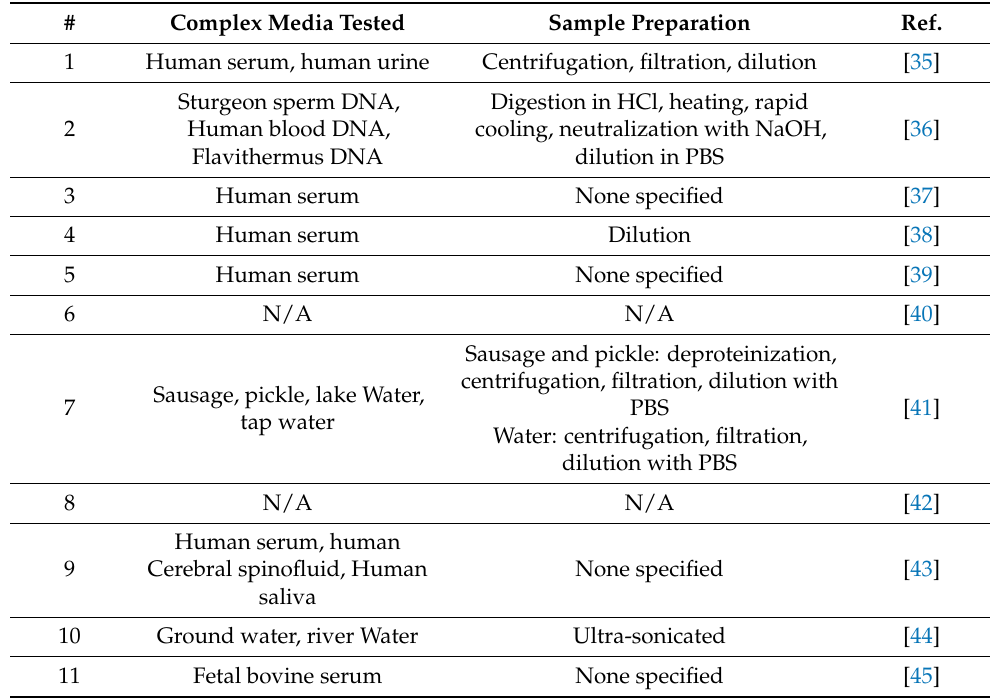
Table 3. Summary of the real sample analysis data for various nanofiber-based electrochemical sensors. The # corresponds to the same designation number in Table